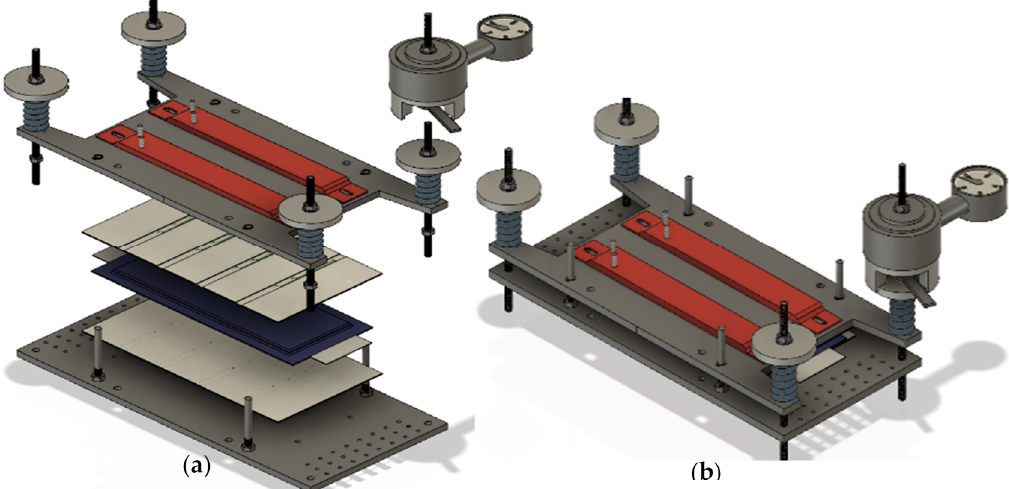
Figure 4. Cell sample holder ( a ) open and ( b ) closed; two heater stripes (red) on the top and two on the bottom side of the stainless-steel plates (dark gray), thermal insolating mica sheets (beige) between the cell (symbolic geometry and design of a pouch cell (blue)) and the stainless-steel plates, thermocouples attached on the mica sheets facing the cell surface.